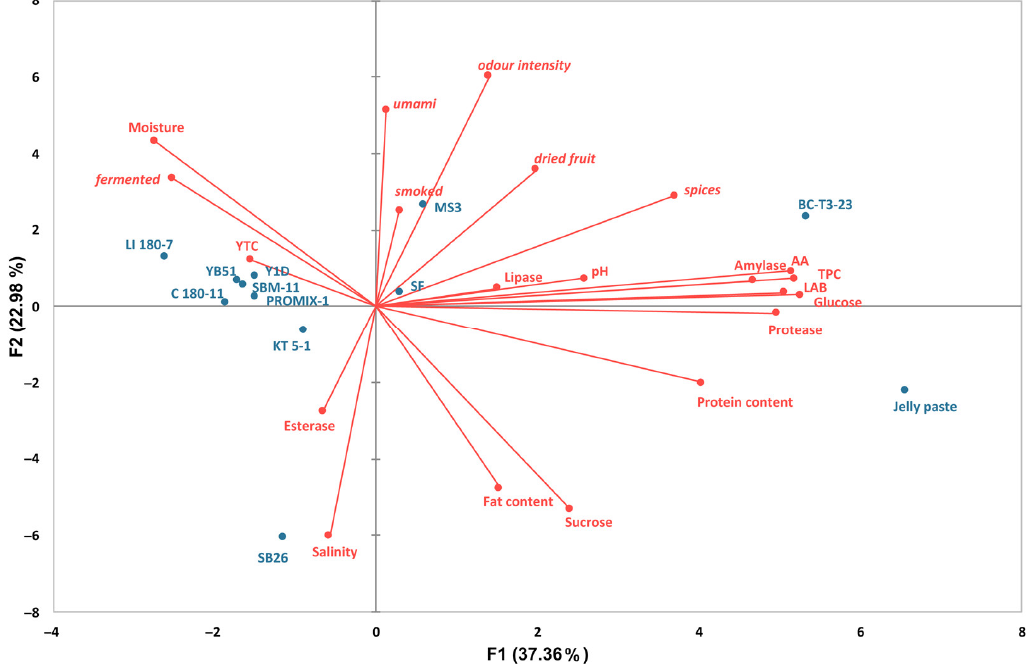
Figure 6. Score scatter plot of PCA model performed on parameters associated with all jellyfish- based fermented samples. PCA variables were the data obtained from the analysis of values of microbiological data, chemical composition, nutritional traits, enzyme-associated activities and odor descriptors at the end of the process.